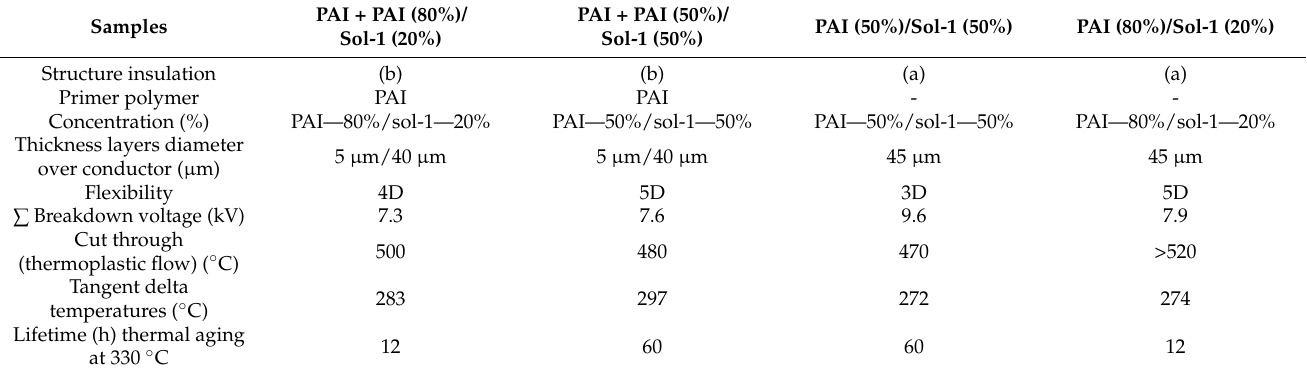
Table 3. Characterization tests of enameled wires using